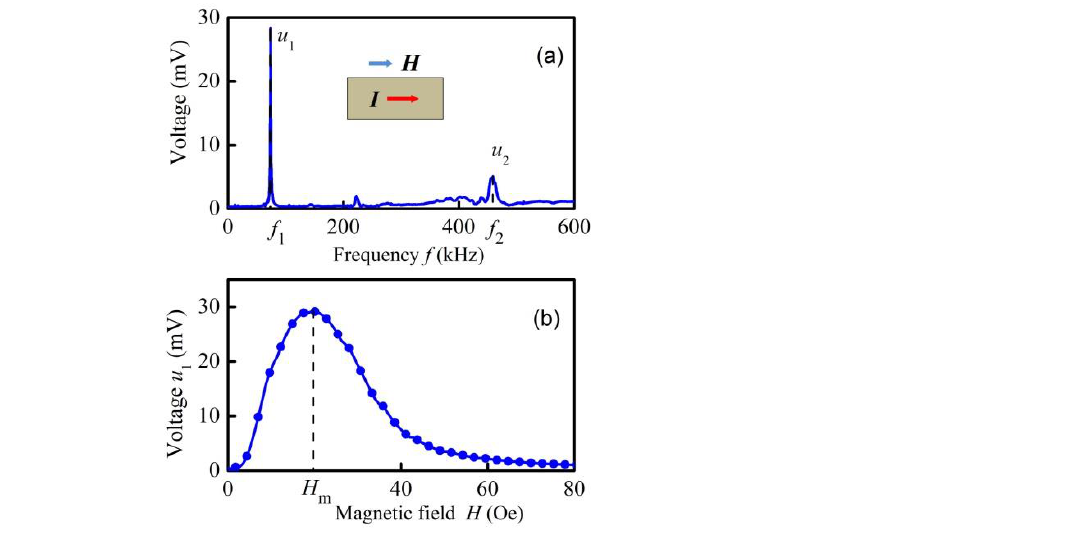
Figure 18. Characteristics of a monolithic Cu-Metglas/PZT/Metglas-Cu structure with integrated excitation system at H // I ; ( a ) ME voltage u vs. frequency f for H = 20 Oe; ( b ) ME voltage u vs. field H for f = 73.3